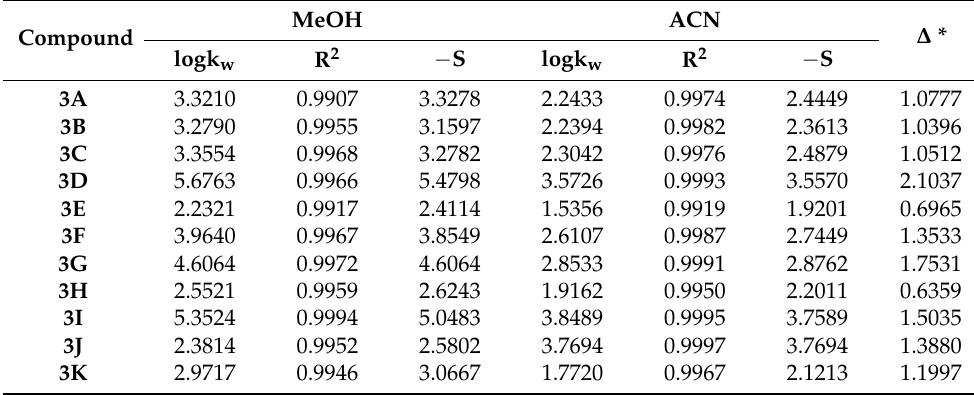
Table 2. The values of lipophilicity determined by the experimental method and the values of parameters describing the Snyder–Soczewi´nski